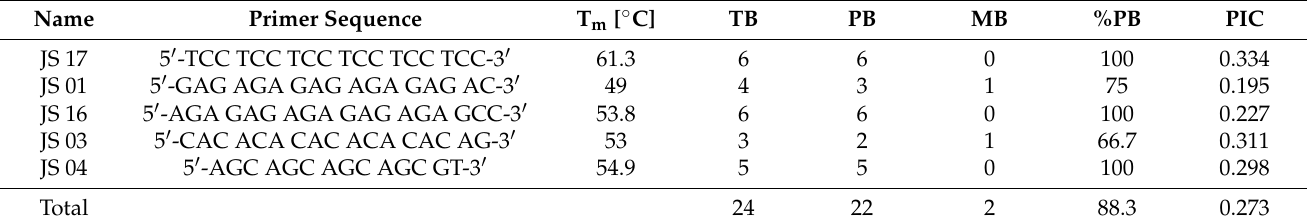
Table 4. Marker parameters calculated for each ISSR primer used with Juniperus sabina var. balkanensis .